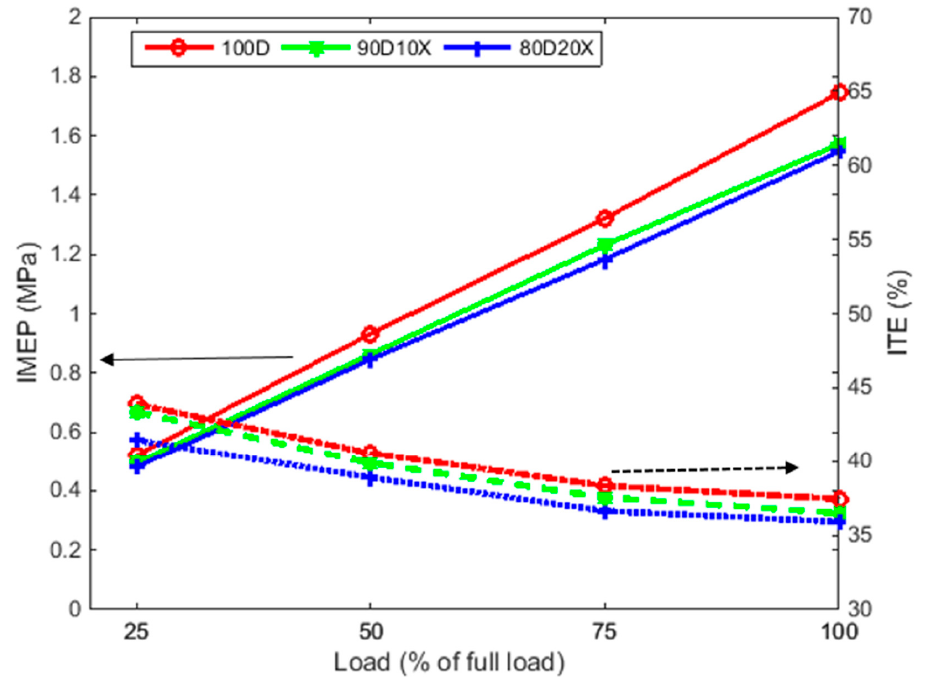
Figure 2. Variation of indicated thermal efficiency and indicated mean effective pressure with engine loads for different fuels.